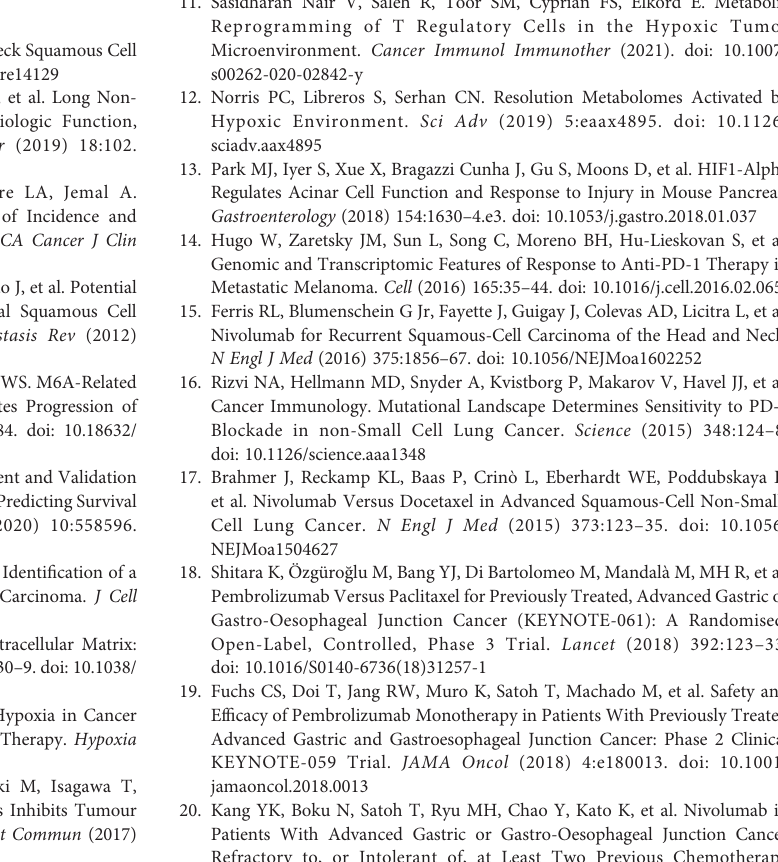
Supplementary Figure 1 | Screening of the signi fi cantly prognostic hypoxia genes in TCGA cohort. (A) Univariate Cox regression analysis of 200 classical hypoxia stimulated genes in TCGA cohort (The forest plot only illustrated the signi fi cant genes). Supplementary Figure 2 | Identi fi cation of the DEGs and related functions between two clusters in TCGA cohorts. (A) The DEGs heatmap between two clusters in OSCC. (B) Cluego illustrated a high correlation with immune cells in fi ltration. Supplementary Figure 3 | The TME characteristics between two clusters in GSE41613cohort. (A) Cluster2patientsconferred lowerimmunescoresandhigher tumor purity than Cluster1. (B) The signi fi cant immune cells difference between two clusters estimated by Cibersort algorithm. (C) EPIC algorithm revealed 7 immune cells difference in two clusters. (D) The CYT score but not the IFNG expression signi fi cantly decreased in Cluster2 patients. (*P < 0.05, **P < 0.01, ***P < 0.001, ****P < 0.0001, NS, not signi fi cant) Supplementary Figure 4 | Compare of two Clusters ’ predicted AUC of another three drugsin TCGAcohorts. (A) TheAUCvalues ofanotherthree agentspredicted from CTRP and PRISM (B) were signi fi cantly decreased in Cluster2 patients. **P < 0.01, ***P < 0.001, ****P <